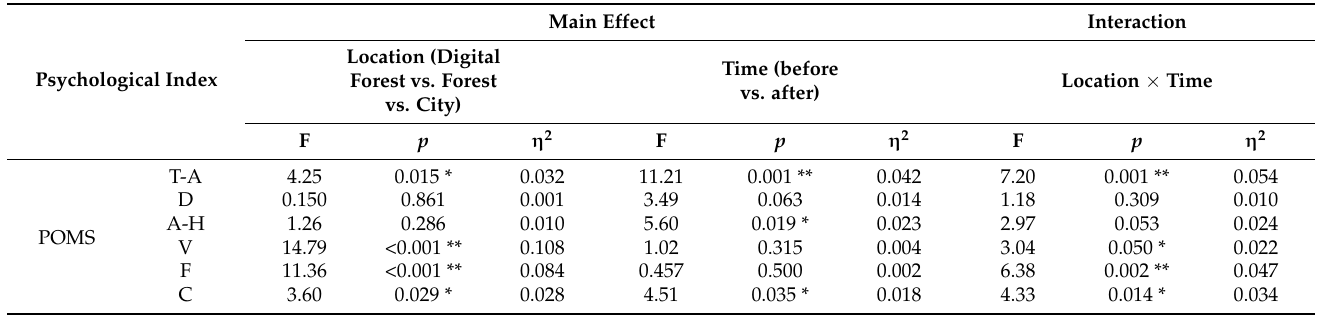
Table 7. Comparative analysis of POMS in three settings (two-way analysis of variance).